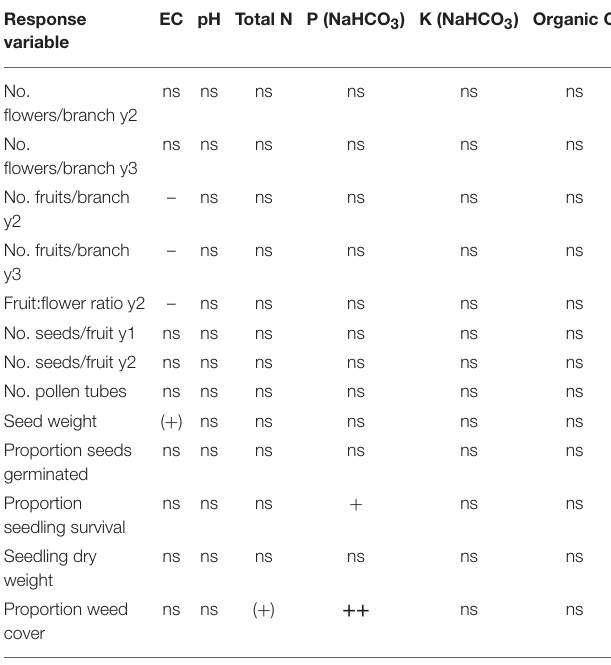
TABLE 4 | Summary of the independent contributions of soil chemical properties to variation in measures of reproduction, progeny performance and weed cover for 19 populations of Eucalyptus wandoo , determined by hierarchical